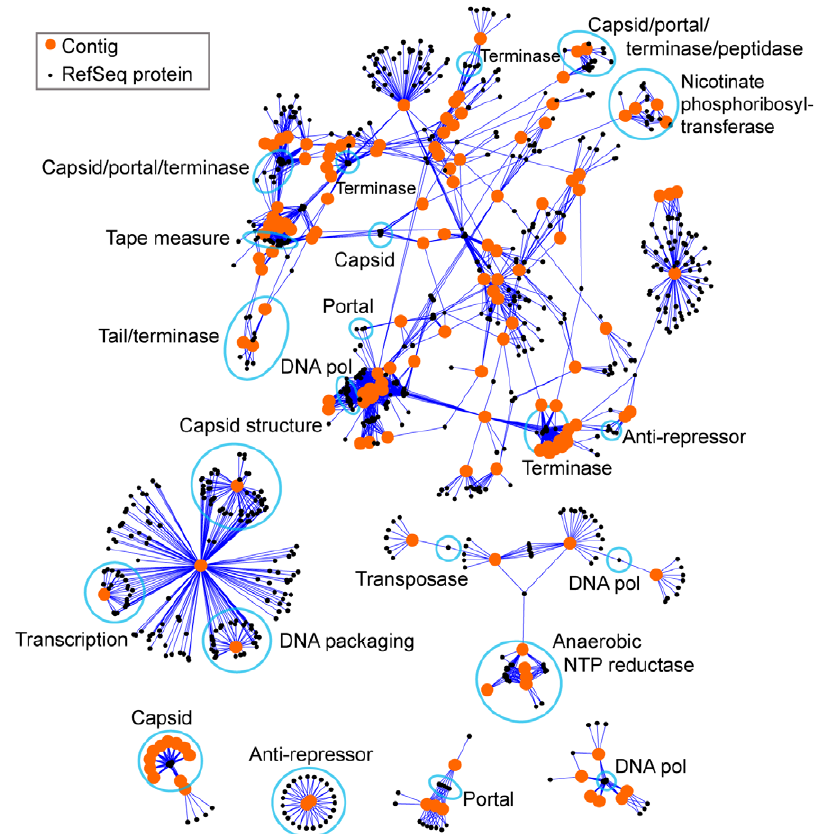
Figure 3. Network based annotation of viral contigs. Orange circles represent viral contigs no shorter than 3 kb. Black circles represent proteins in the RefSeq viral database. RefSeq proteins are connected to viral contigs when an ORF encoded by that contig resembles that protein at E , 10 2 50 (blastp). Blue outlines indicate groups of RefSeq proteins and ORFs from contigs that share the function indicated by the adjacent label.